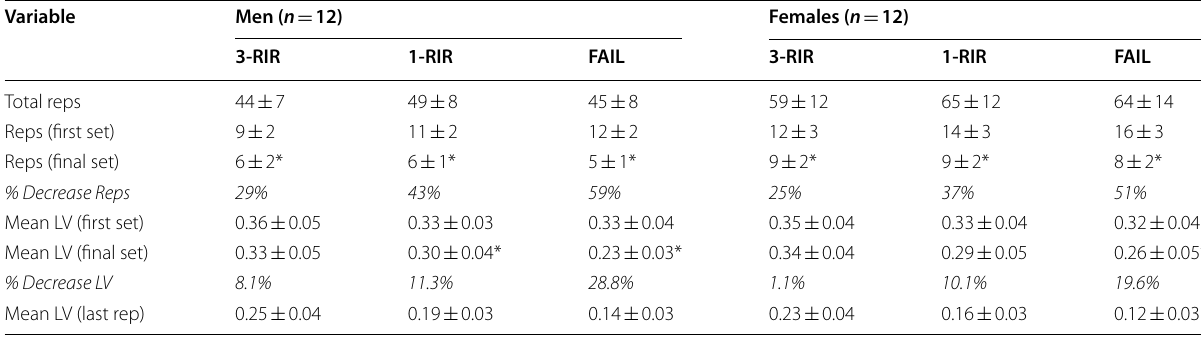
Data shown are presented as mean SD. Lifting velocity values represent mean velocity of the concentric portion of a repetition (m s − 1 ). ± *Denotes a statistically significant within-protocol difference from the first set. LV, lifting velocity; reps,